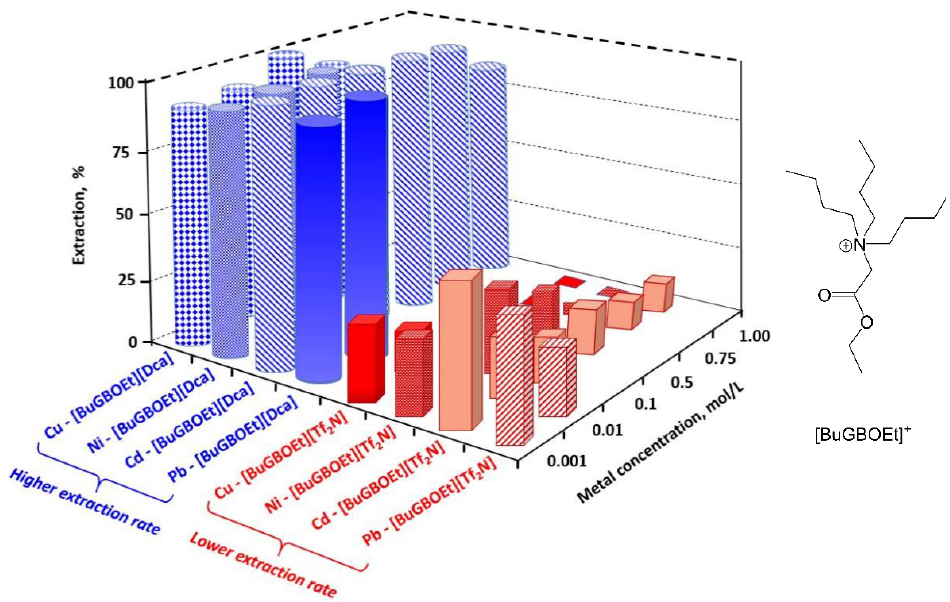
Figure 2. Extraction yields (%E) for Cu 2+ , Ni 2+, Pb 2+, and Cd 2+ extracted with cationic ester derivative of betaine tri( n -butyl)[(2-ethoxy-2-oxoethyl]ammonium salts: [DCA] − (blue) and [Tf 2 N] − (red). Data from